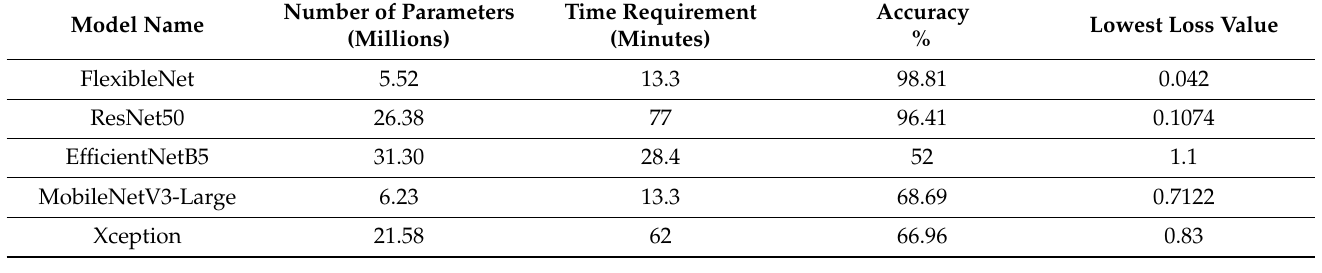
( n ) Figure 9. Different sub-images showing ( a – g ) the original Sentinel-2 images and ( h – n ) canopy den- sity (very low, low, medium, high, and very high). The FlexibleNet was compared with four popular and well-known convolutional neural networks: the large model ResNet50 [8], the lightweight models Xception [13] and